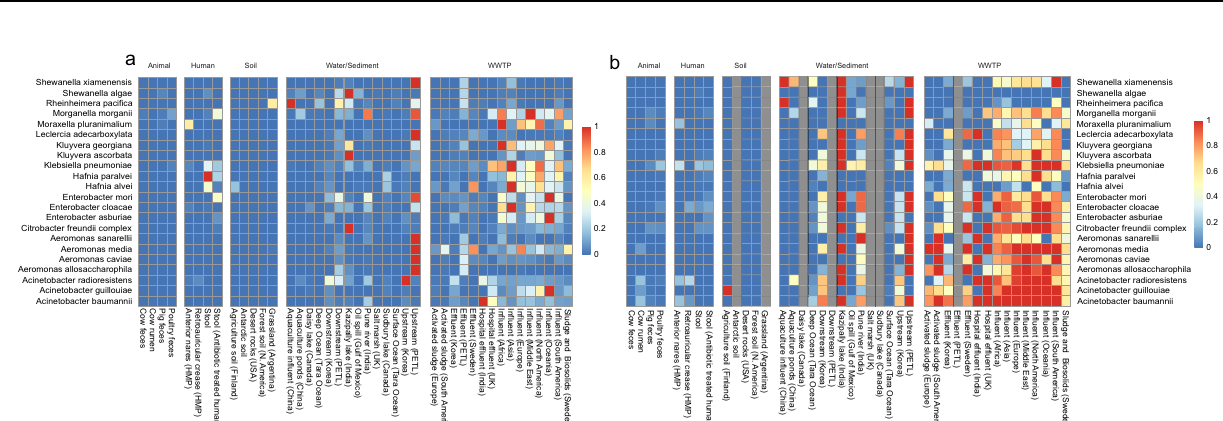
Fig. 1 Relative abundance and prevalence of 22 known origin species. Average relative abundance of the 22 investigated origin species in different environments (2496 samples) normalized by each species ’ highest relative abundance ( a ), and the prevalence of the 22 investigated origin species as fraction of samples with detectable levels of the corresponding species within each environment type ( b ). Some environments are excluded from the analysis in ( b ) due to too few identi fi ed bacterial